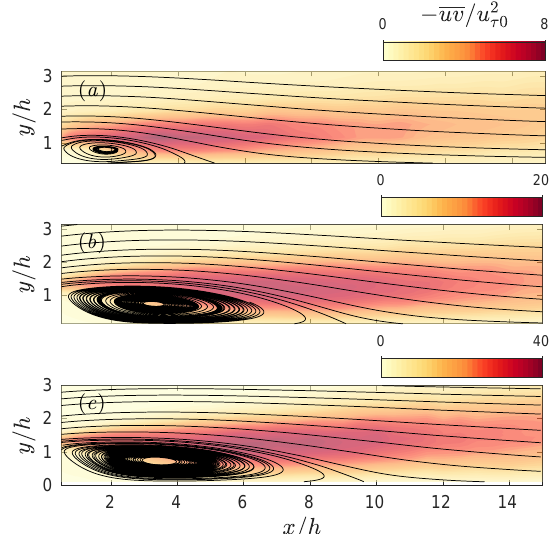
Figure 5. Mean streamlines near the separation bubble and flow reattachment distance. ( a – c ): h / R = 0.04, 0.1,